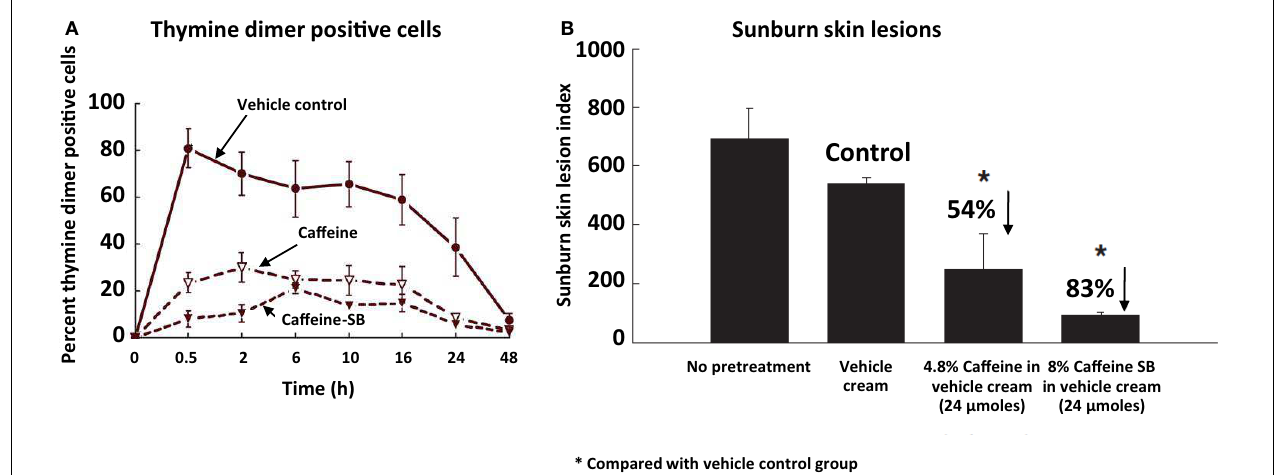
(7–8weeks old; 5 mice/group) were treated topically with 100mg vehicle cream, or 24 µ mol of caffeine or caffeine-SB in vehicle cream 0.5h before UVB (180mJ/cm 2 ), and these treatments were repeated 24h later.The area (mm 2 ) and the intensity of red color in UVB-induced skin lesions were estimated 5days after the first UVB treatment.The sunburn lesion index was calculated as the lesion area (mm 2 ) multiplied by the arbitrary intensity: 0, no lesion; (1) barely detectable red lesion; (2) moderate red lesion; and (3) bright red lesion. Each value is the mean ± SE from five mice. % inhibition was calculated by comparing with the vehicle cream group (Control).Taken from Lu et al. (2007).